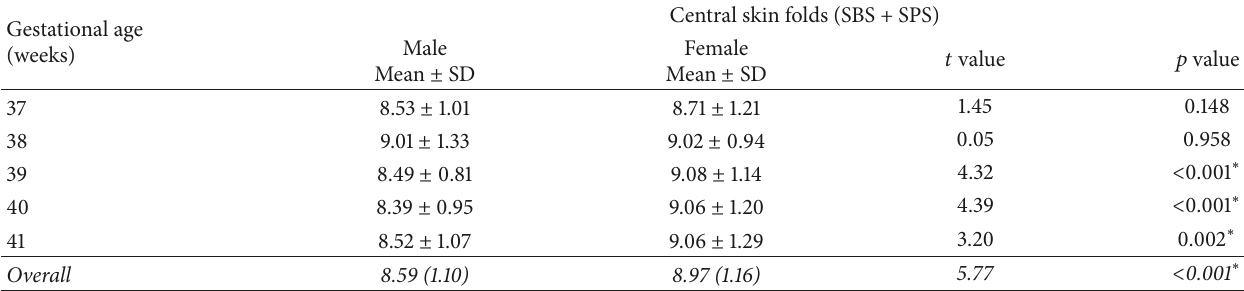
Table 3: Distribution of central skinfolds according to sex and gestational age.